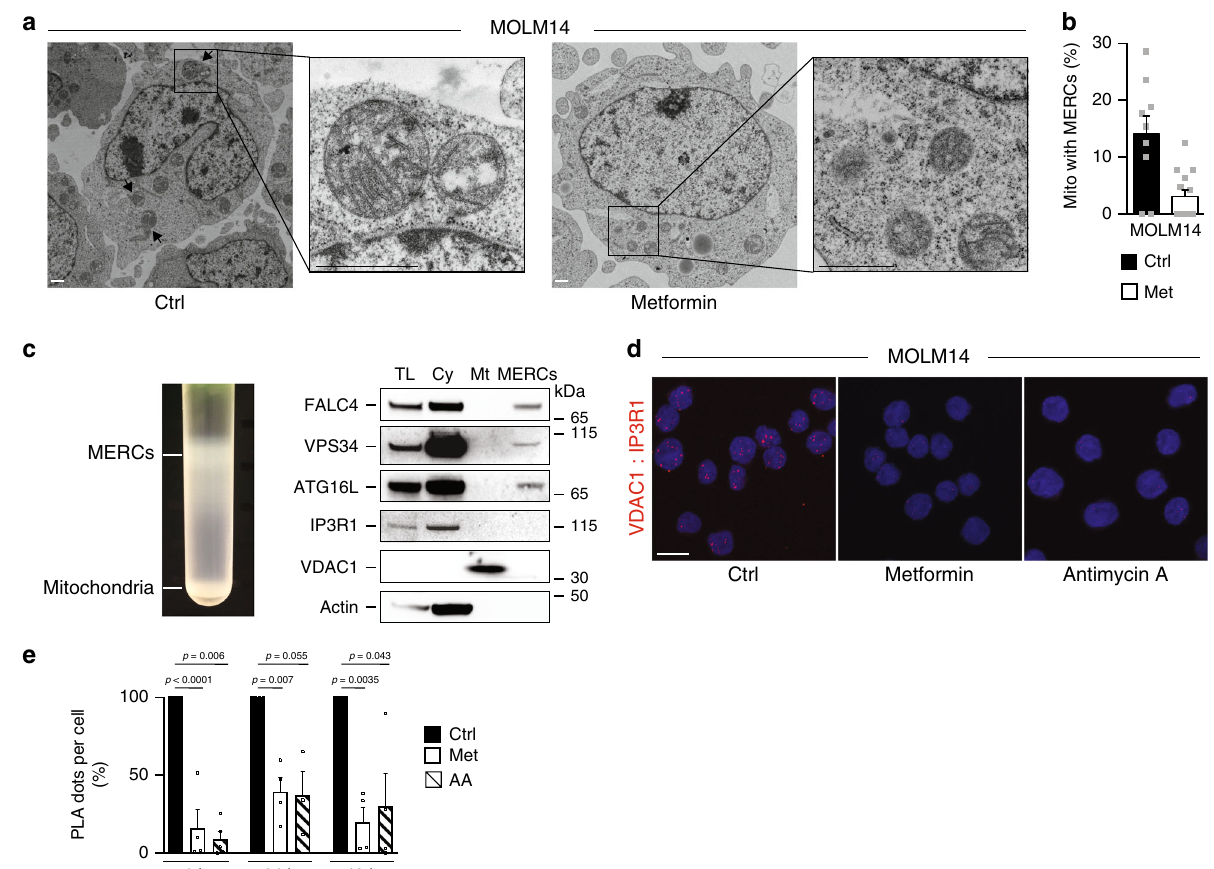
Fig. 4 OxPHOS regulates MERCs number and function. a MOLM14 cells treated with metformin (Met, 10 mM) for 24 h were fi xed and processed for electron microscopy analysis. Representative electron microscopy pictures from two independent experiments are shown. Arrows indicate MERCs. Scale bar: 1 µ m. b Histograms represent the % of mitochondria that are in contact with endoplasmic reticulum per cell treated or not with Met from pictures displayed in a . Data are means ± s.e.m with each dot corresponding to one cell. c Protein components of subcellular fractions (left panel) from two independent experiments prepared from MOLM14 cells revealed by immunoblot analysis (right panel). TL: total lysate, Cy: cytosol, Mt: pure mitochondrial fraction, MERCs: mitochondria – ER contact site fraction. d Representative orthogonal confocal projections of Z sections of PLA (red signal) between VDAC1 and IP3R1 from MOLM14 cells treated or not with Met or antimycin A (AA) for 48 h (at least n = 3). Scale bar: 10 µ m e Quantitative analysis of PLA signal between VDAC1 and IP3R1 from MOLM14 cells treated or not with Met or AA for 6 h, 24 h or 48 h ( n = 4, one-sample t -test). Data are means ±